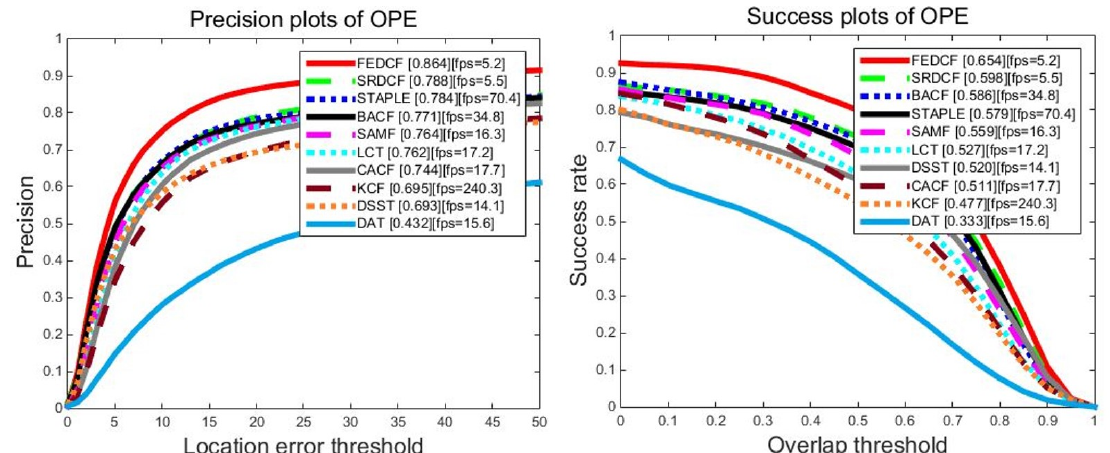
Figure 9. The precision plots and success plots of FEDCF and compared trackers with one-pass (OPE) evaluation on OTB2015, which expands the contained sequences to 100 challenging sequences with 11 challenging attributes.